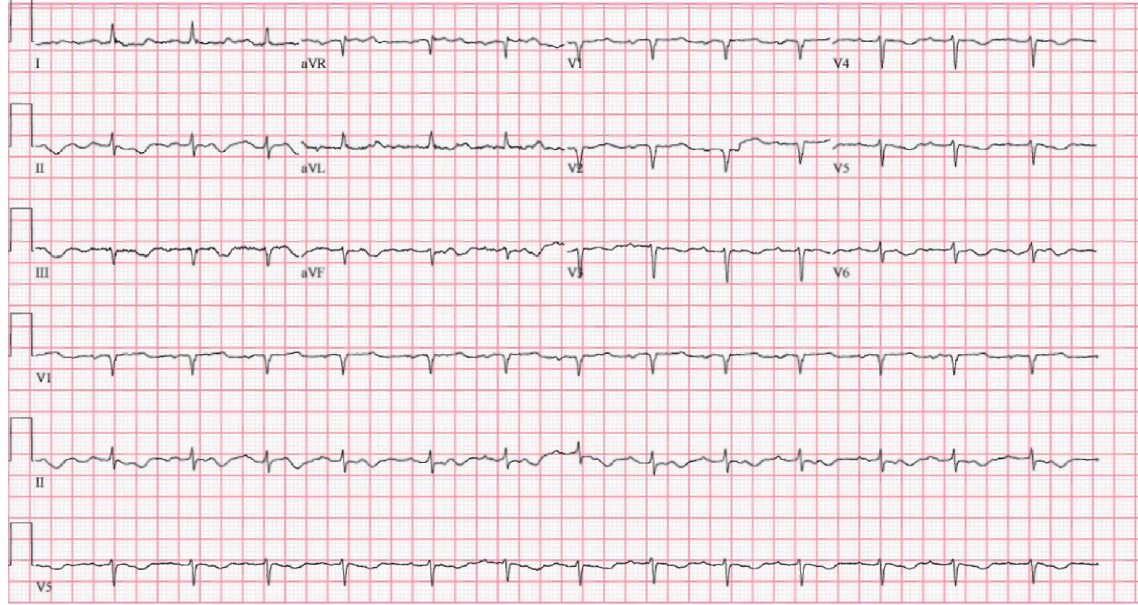
Figure 1: Electrocardiogram on admission showing sinus rhythm with low voltage, prior infarct of anteroseptal regions, and T-wave inversions in lateral leads.